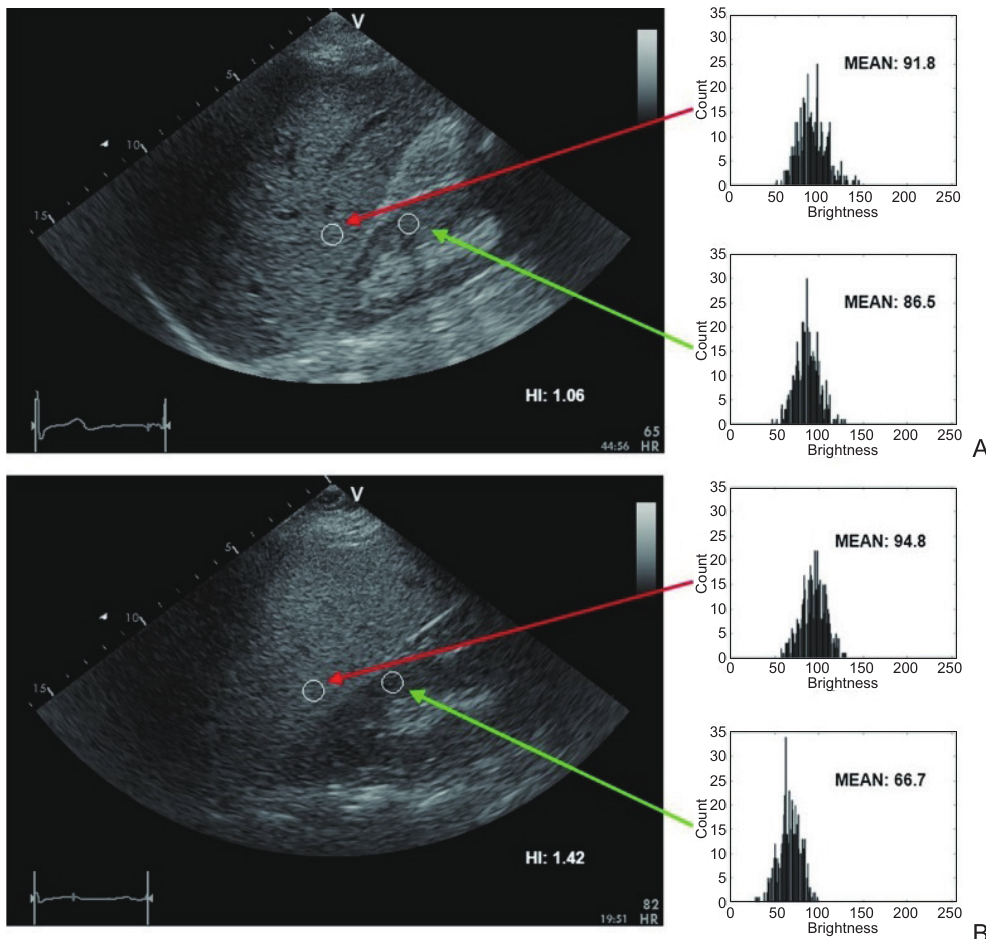
Figure 7 Liver B-mode images and the region of interest (ROIs) selected for hepatorenal sonographic index (HI) calculation, (A) steatosis level of 3% and (B) 25%, respectively. (Reprinted with permission from